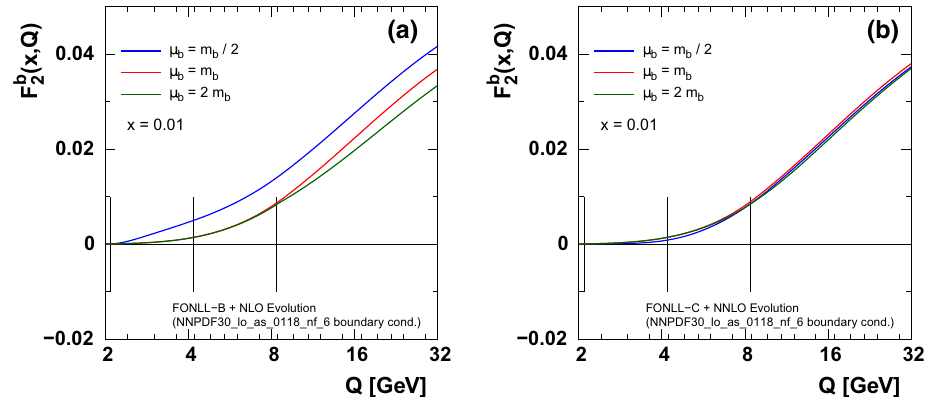
( x , Q ) for different choices of the matching scales μ 2